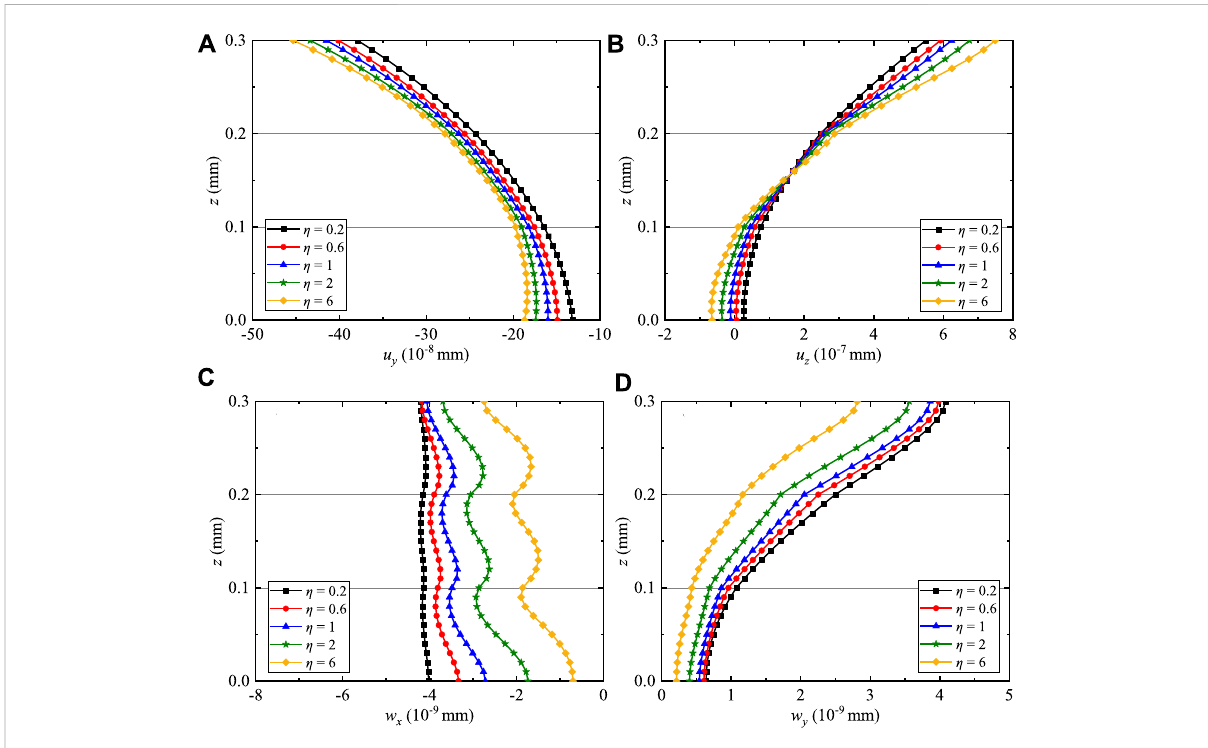
FIGURE 3 Variation of the phonon and phason displacements for QC coating structures: (A) u x , (B) u z , (C) w x , and (D) w y